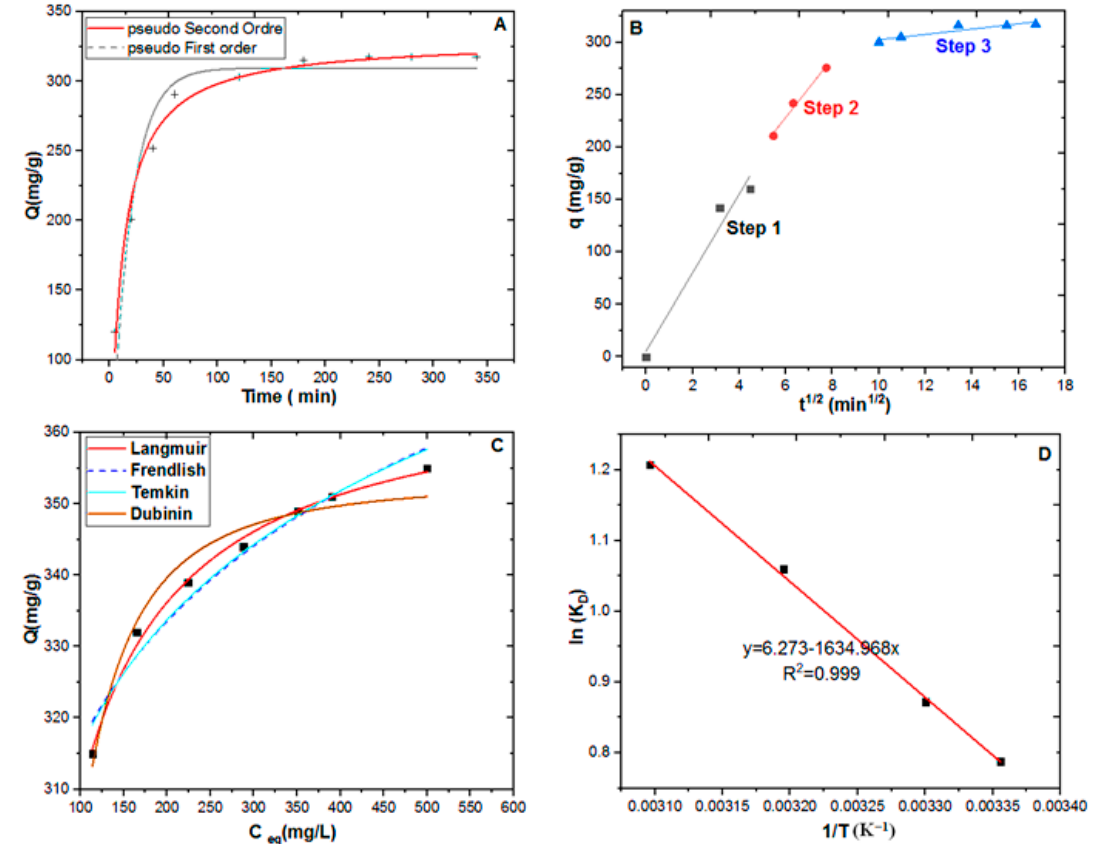
Figure 3. Modeling of adsorption of MeO on MO C-ZnCl2. ( A ) Kinetics: PFO and PSO, ( B ) Intraparticle diffusion, ( C ) Isotherm, ( D ) Representation of the Van’t Hoff line .